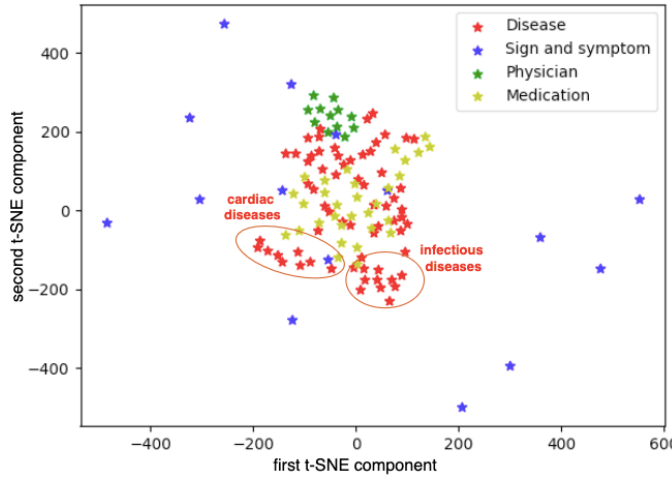
Figure 12. Space of vector word representations, labeled with vocabularies, obtained by the Node2Vec method.